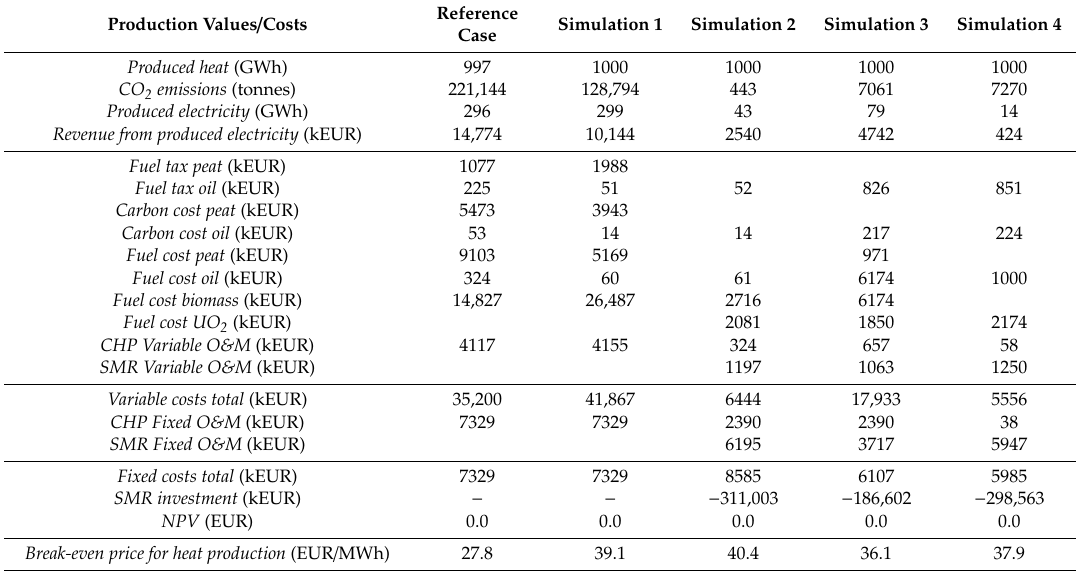
Table 5. Economic data for the simulated cases. Discount rate r = 6% for all